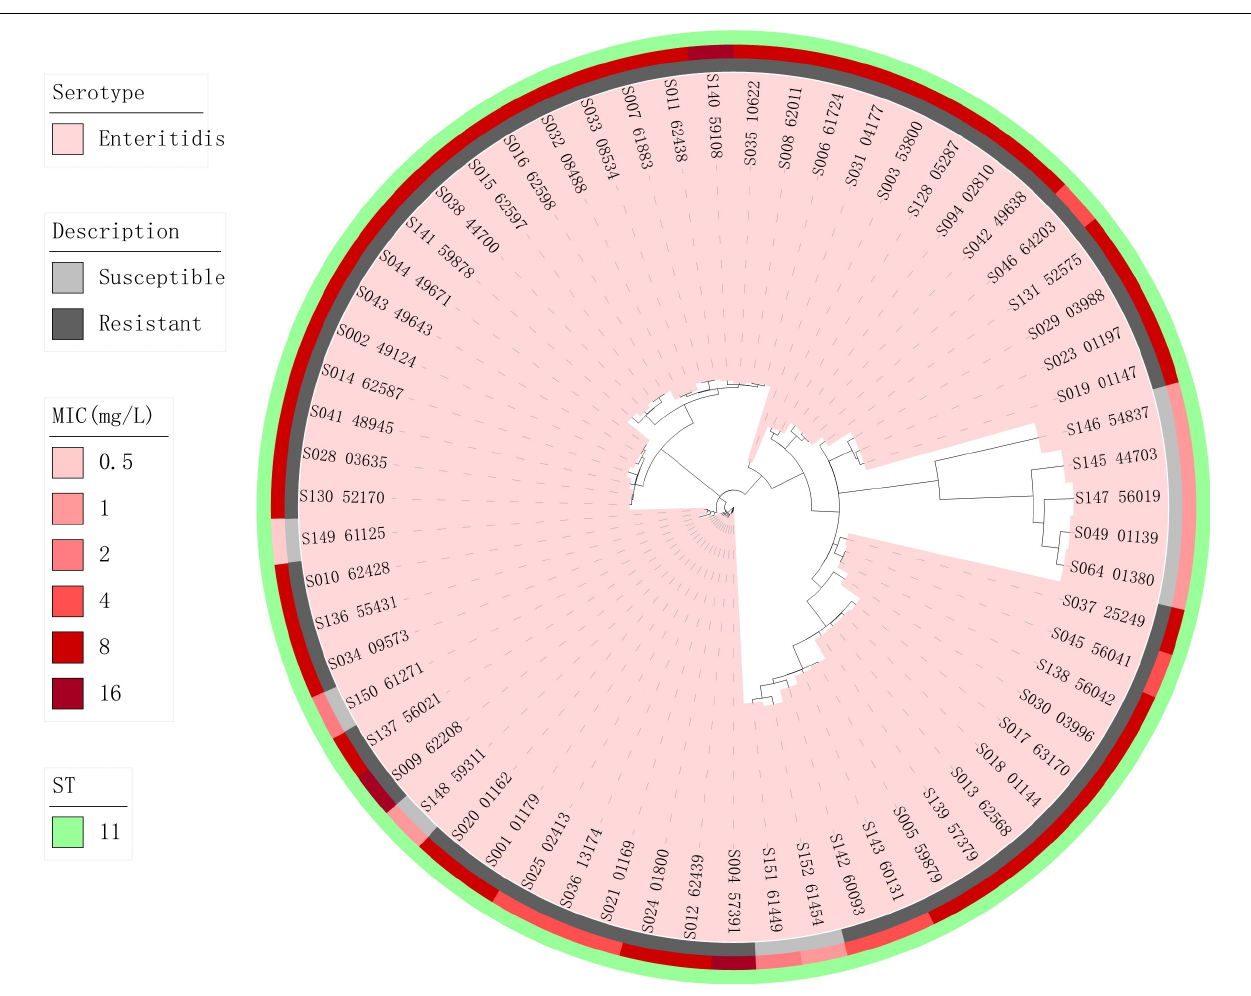
FIGURE 3 | Zoomed-in maximum parsimony tree showing the Enteritidis serotype sub-clade of the clinical Salmonella isolates. Colistin MICs in mg/L and sequence types are shown. For the description of colistin susceptibility, resistance corresponds to MIC > 2 mg/L and susceptible corresponds to MIC ≤ 2 mg/L.